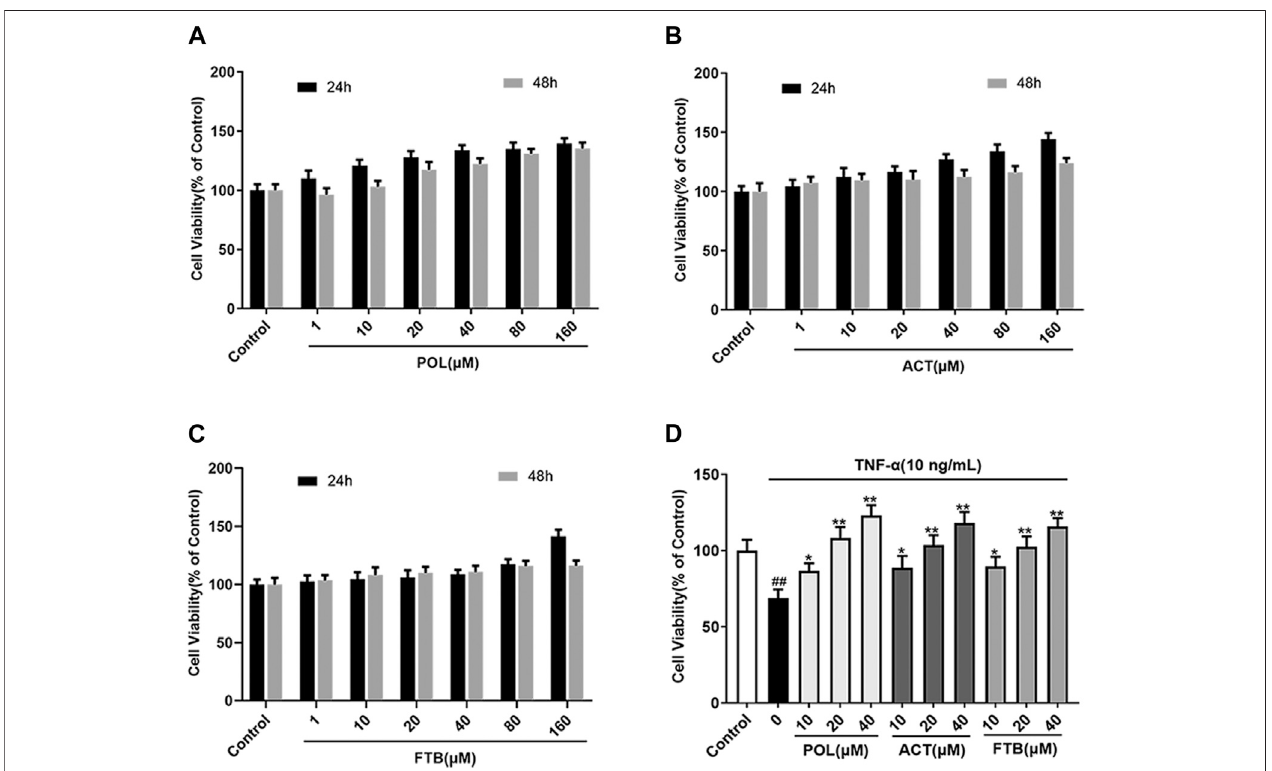
FIGURE 2 | Effects of POL, ACT, and FTB on A549 cells. (A – C) Effects of treatment with POL, ACT, FTB (1, 10, 20, 40, 80, and 160 μ M) for 24 and 48 h on the viability of A549 cells. (D) Cell viability was measured by stimulating with TNF- α (10 ng/ml) for 24 h, and then treated with POL, ACT, and FTB (10, 20, and 40 μ M) for 24 h. Values represent the means ± SD ( n (cid:2) 6). ## p < 0.01 vs control; * p < 0.05, ** p < 0.01 vs TNF- α